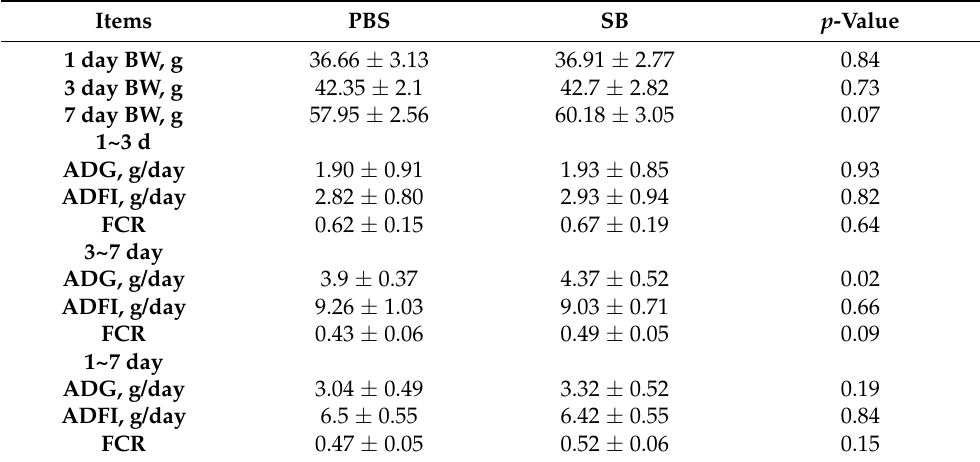
Table 2. Effects of S. boulardii early intervention on the growth performance of early-weaned rats. Items